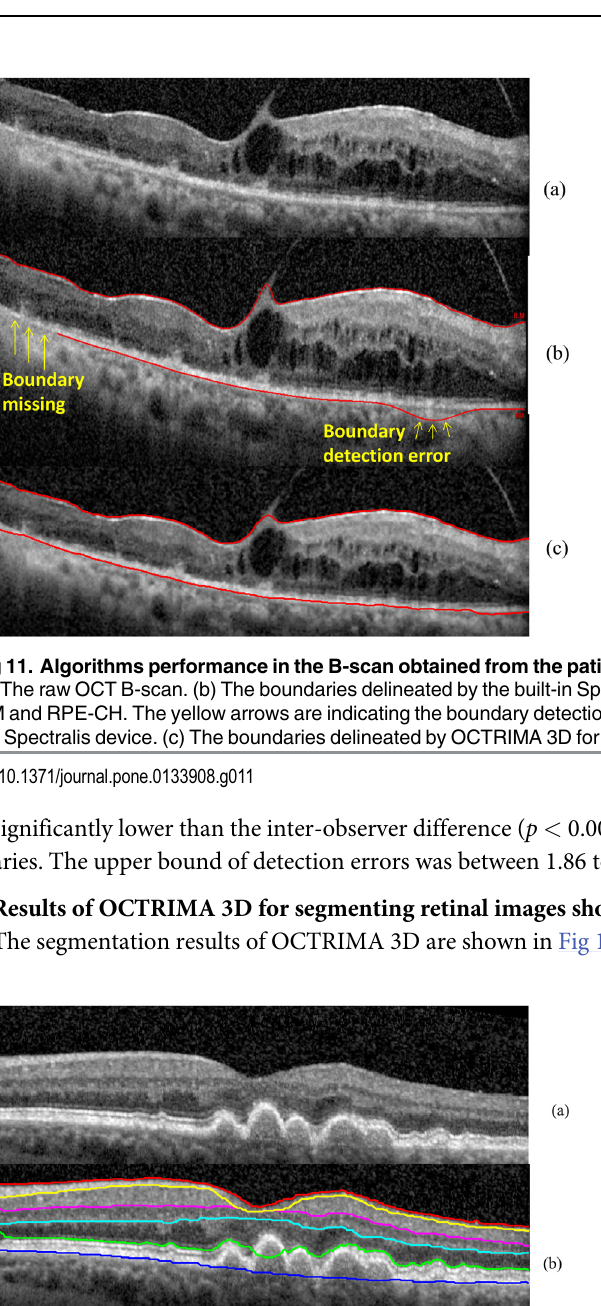
Fig 12. The segmentation results obtained for the B-scan in the eye with dry age-related macular degeneration using Dufour ’ s software and the OCTRIMA 3D algorithm. The legend of the boundaries is the same as Fig 1. (a) THe raw OCT B-scan. (b) The segmentation result of Dufour ’ s software. The IS-OS delineation failed at the left most and center area of the B-scan. (c) The initial segmentation results of OCTRIMA 3D detected retinal boundaries reliably except for the IS-OS in the drusen area (green doted line). By adjusting the flattening step, the IS-OS is delineated correctly (green solid